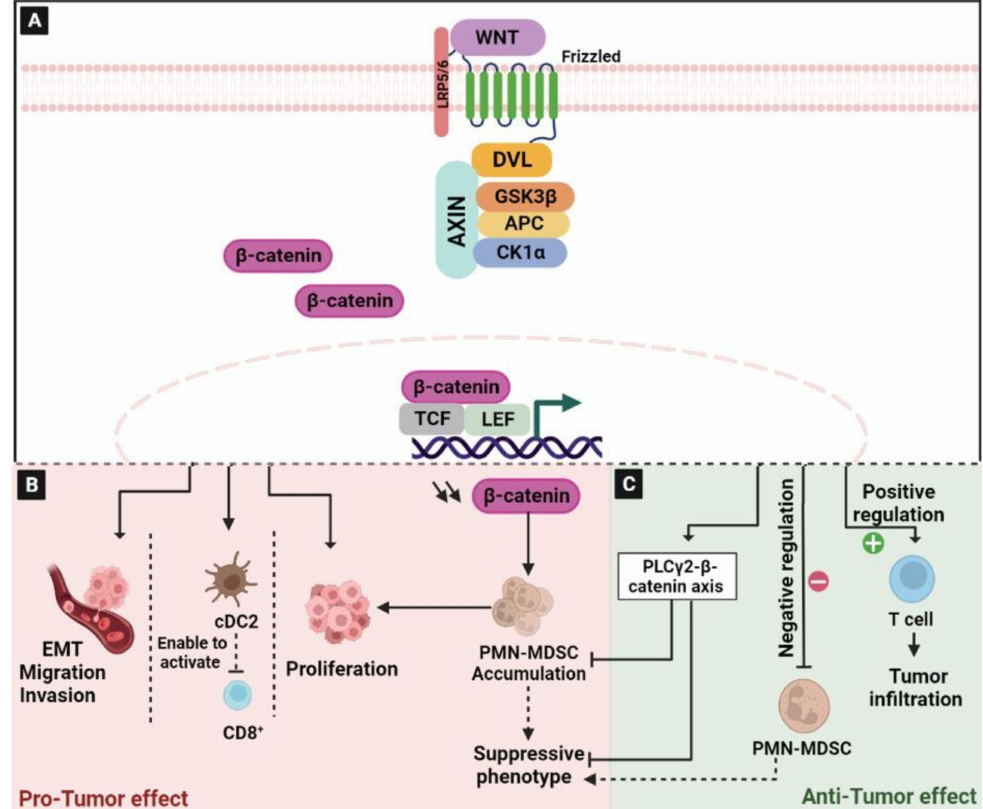
Figure 1. The dual function of Wnt/ β -catenin signaling pathway in colorectal cancer. ( A ) Schematic representation of activated Wnt/ β -catenin pathway: The ligation of WNT to their receptor Frizzled/LRP5/6-activated DVL and acted as a suppressor of GSK3 β . This inhibition induces the accumulation of β -catenin in the cytoplasm. Subsequently, β -catenin is translocated into the nucleus and binds to TCF/LEF transcription factors, leading to the target genes’ transcription. ( B ) The wnt/ β -catenin pathway increases the proliferative rate of tumor cells, accelerates the process of the EMT, and enhances the metastatic properties of cancer cells. In addition, β -catenin can regulate the CCL 4 expression to recruit cDC2 to enable CD8+ T cell activation. The down-regulation of β -catenin is critical for MDSC accumulation, which leads to the suppression of T-cell responses and promotes tumor proliferation. ( C ) β -catenin is a negative regulator of PMN-MDSCs and a positive regulator of T cell function. In addition, PLC γ 2- β -catenin axis inhibits the accumulation and suppressive phenotype of PMN-MDSCs. Abbreviations: Wnt: Wingless/integrated, LRP5/6: Lipoprotein Receptor-related Protein 5/6, DVL: Dishevelled, GSK3 β : Glycogen synthase kinase-3 beta, APC: Adenomatous Polyposis Coli, CK1 α : Casein kinase-1 alpha, TCF: T-Cell Factor, LEF: Lymphoid Enhanced Factor, PMN-MDSC: Polymorphonuclear Myeloid-derived suppressor cells, EMT: Epithelial–Mesenchymal Transition, cDC2: Conventional Dendritic Cell 2, PLC γ 2: Phospholipase C γ